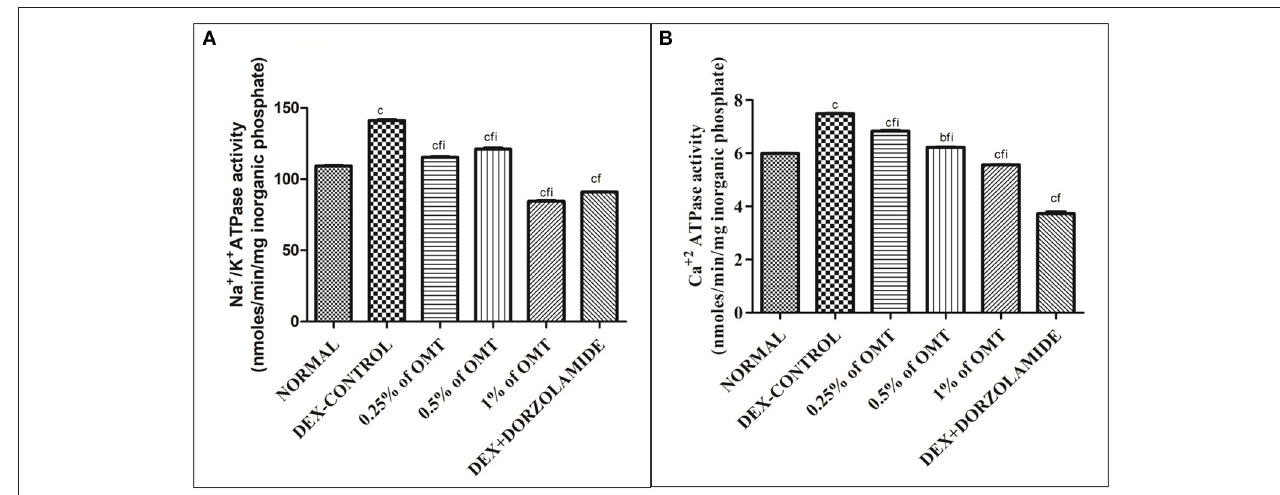
FIGURE 5 | Effects of various treatments on the ATPase activity in the retinal layers: (A) Na + /K + ATPase and (B) Ca + 2 ATPase. Values are expressed as mean ± SEM ( n = 6). Data were analyzed by one-way ANOVA and are expressed as a p < 0.05, b p < 0.01, and c p < 0.001 when compared to normal group, d p < 0.05, e p < 0.01, and f p < 0.001 when compared to DEX-induced glaucoma control group, and g p < 0.05, h p < 0.01, and i p < 0.001 when compared to standard group, respectively. Normal: 100 µ l of distilled water; control: 0.1ml of 0.1% DEX solution; treatment 1: 50 µ l of 0.25% OMT solution; treatment 2: 50 µ l of 0.5% OMT solution; treatment 3: 50 µ l of 1% OMT solution; standard: 100 µ l of 1% of dorzolamide solution.